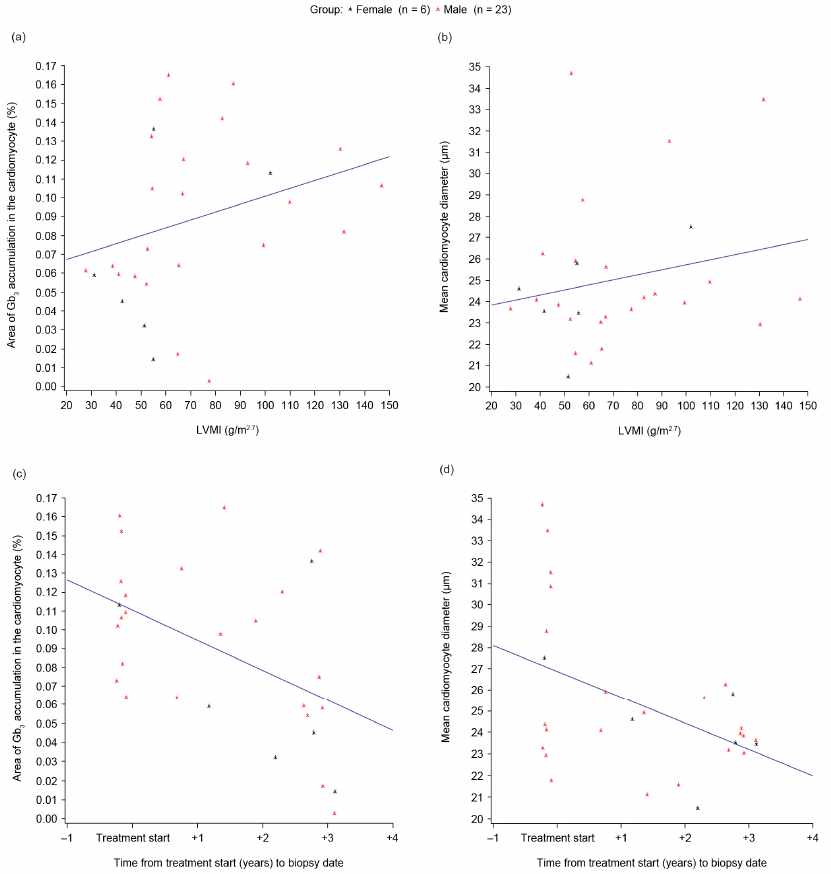
Figure 1. Scatter plots illustrating: ( a ) Globotriaosylceramide (Gb3) accumulation by left ventricular mass indexed to height (LVMI); ( b ) Cardiomyocyte size by LVMI; ( c ) Gb3 accumulation by time from treatment start to biopsy date; ( d ) Cardiomyocyte size by time from treatment start to biopsy date. Left ventricular hypertrophy was defined as LVMI of >51 g/m 2.7 in males and >48 g/m 2.7 in females